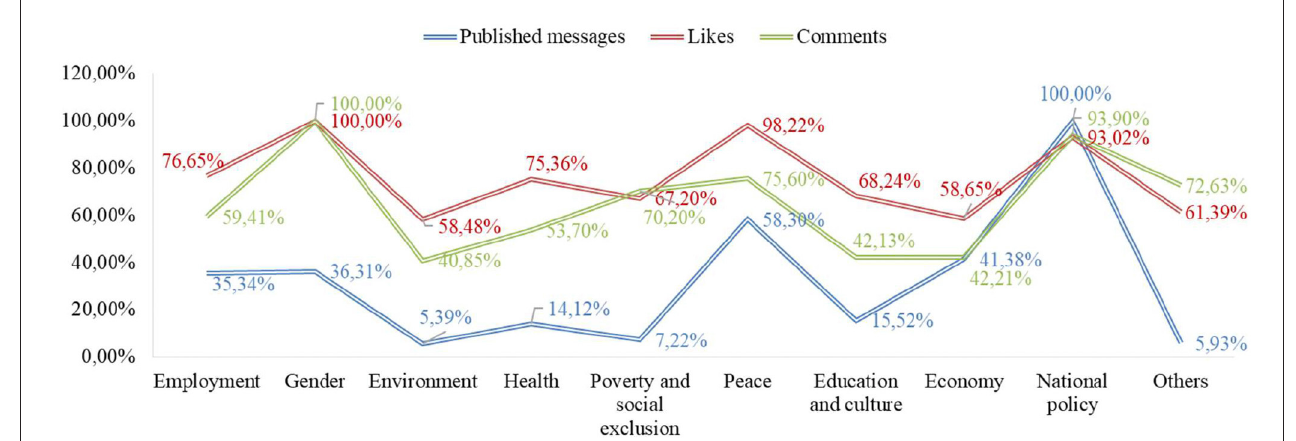
FIGURE 3 | Communication profiles of political parties according to the social topic. Source: Own elaboration. Retrieved from